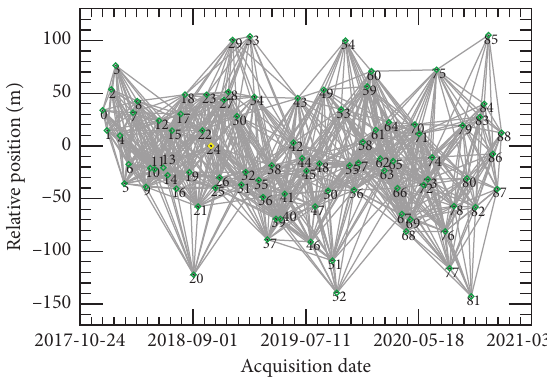
Figure 4: Spatiotemporal baseline combination of the data collection.